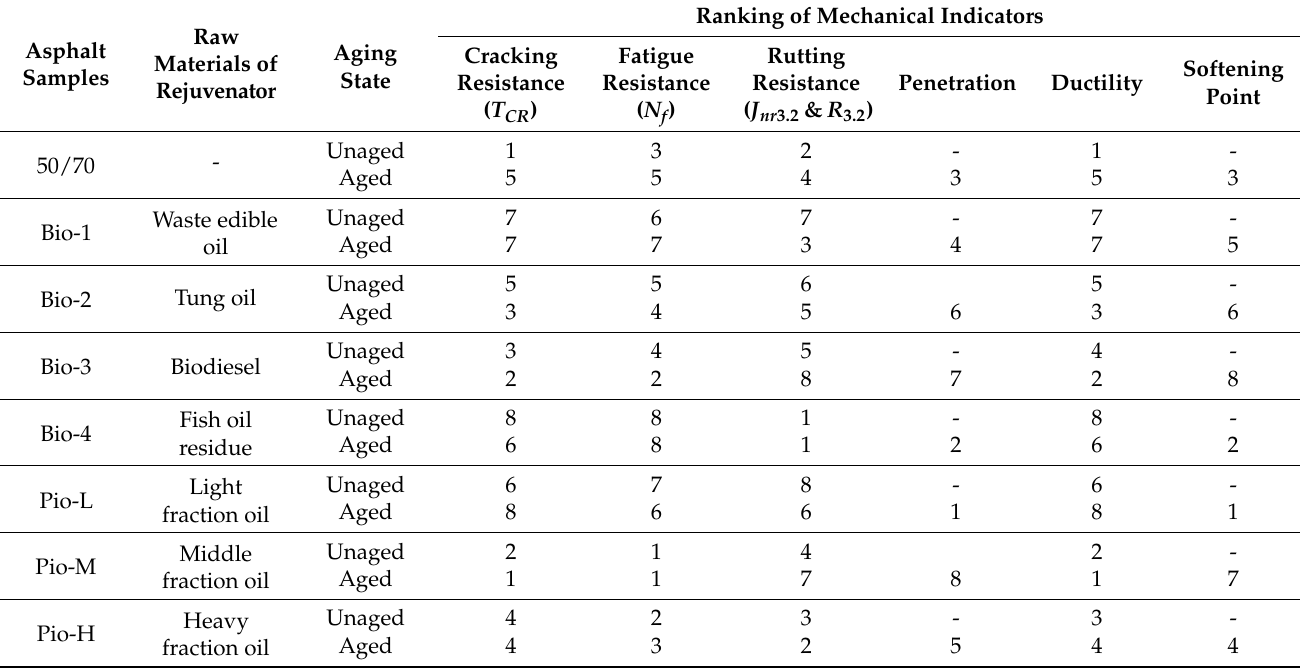
Table 4. Ranking of the mechanical indicators of all the asphalt